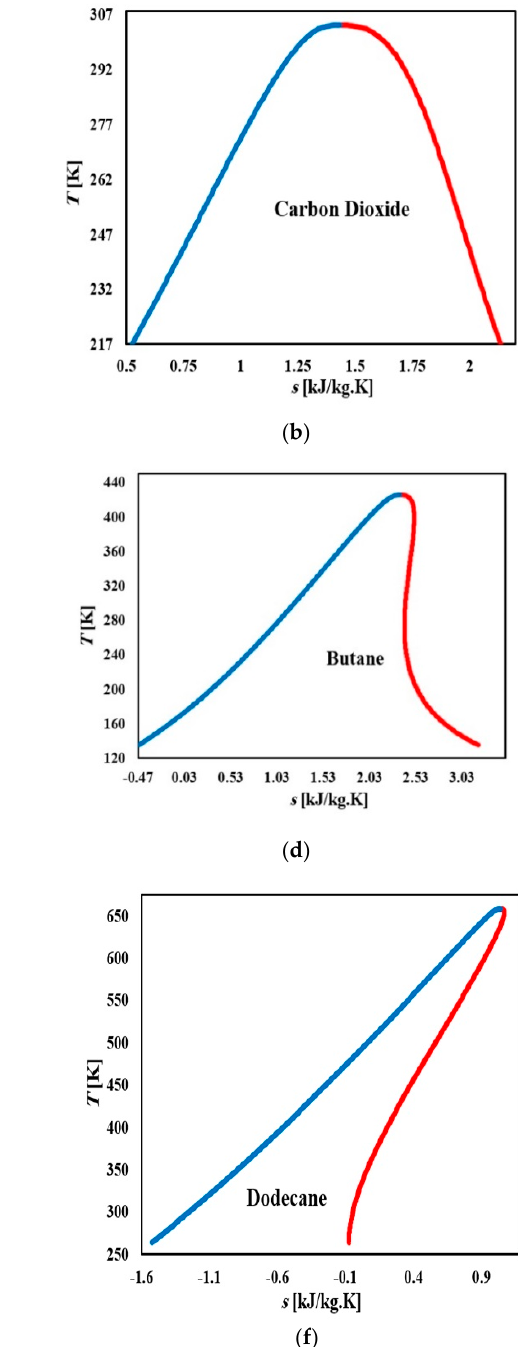
Figure 2. Temperature dependencies of ORC (or other Rankine-like) and TFC cycles for various working fluids (Water ( a ), CO 2 ( b ), R116 ( c ), Butane ( d ), Neopentane ( e ), Dodecane ( f )); see text for further explanation.